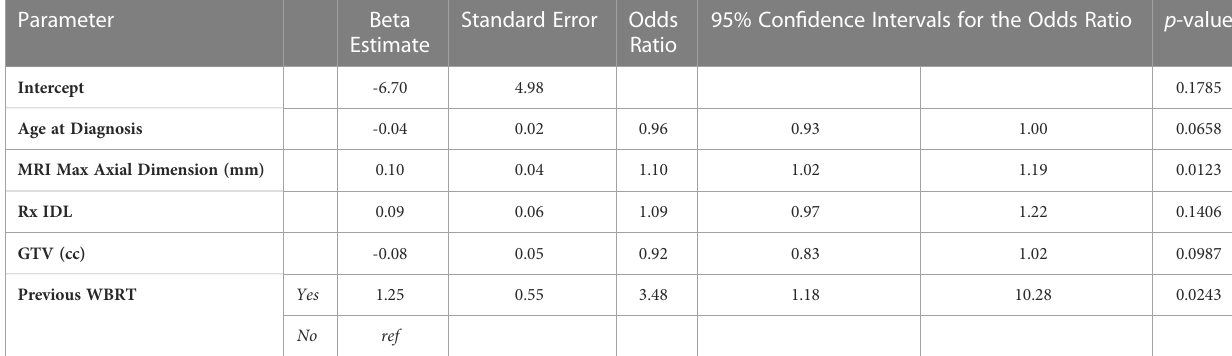
TABLE 2 Multivariate Generalized Estimating Equations (GEE) for